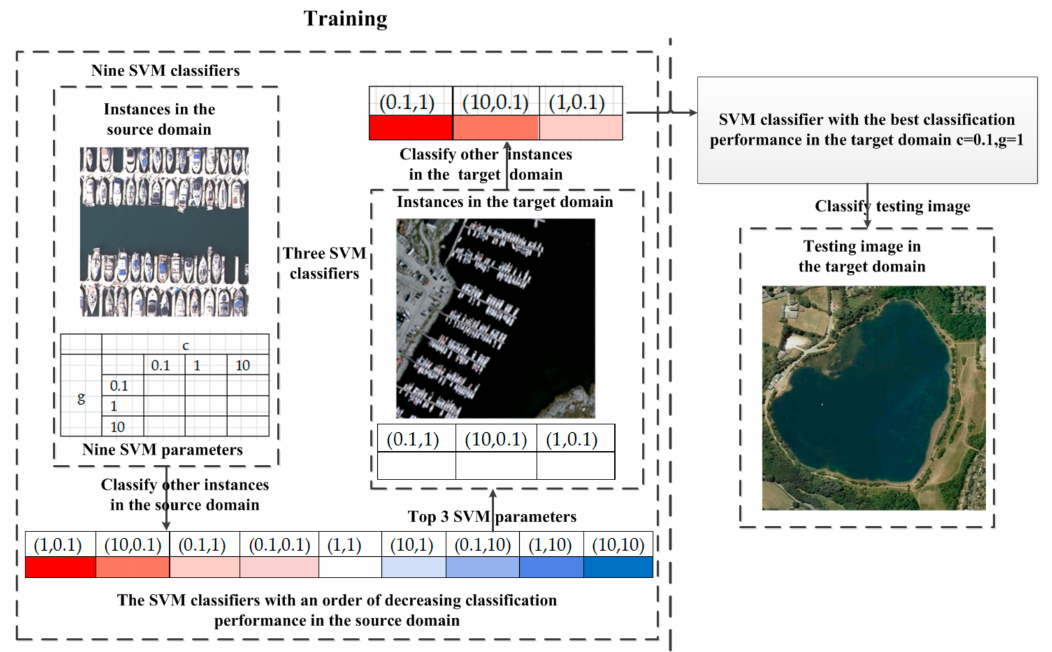
Figure 6. The sketch map of transferring SVM parameters from the source domain to the target domain. The color indicates the performance of the classifier with a decreasing order (from dark red to dark